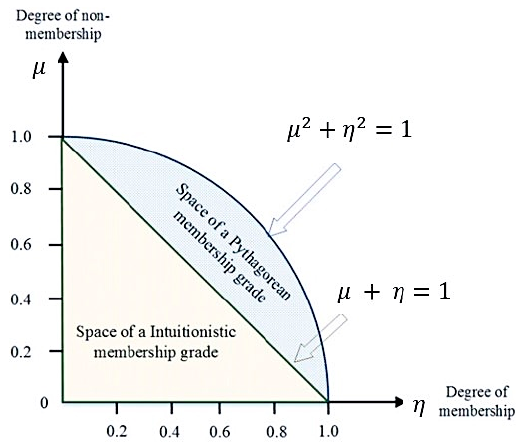
Figure 3. Space of Pythagorean membership grade.